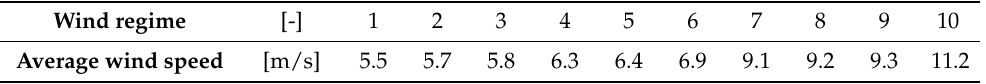
Table 1. Average annual wind speed of the different wind regimes.